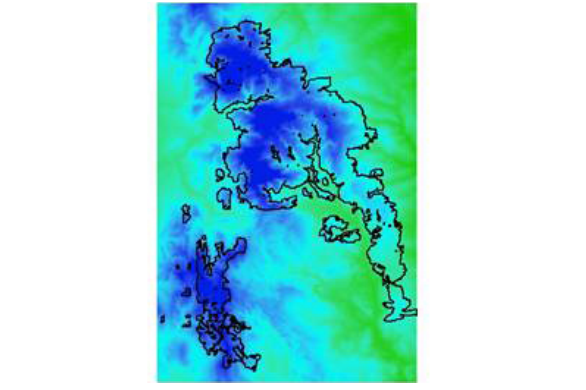
Fig. 4 . Ratio of average annual rainfall and potential evapotranspiration in the Peak District National Park, showing areas in light blue and green where soils tend to be drier toward the east of the park, areas where scrub and forest are most likely to encroach in the absence of management for sheep and